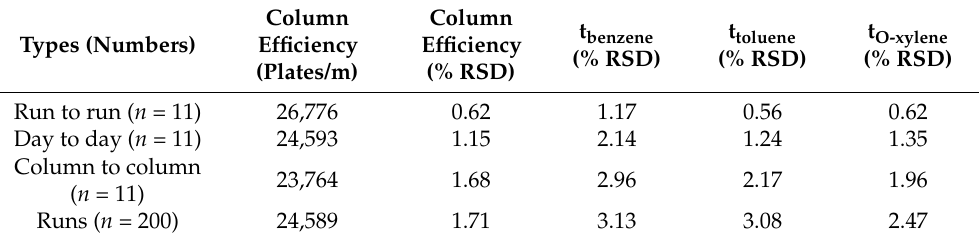
Table 1. Reproducibility and stability of the TpBD COF immobilized